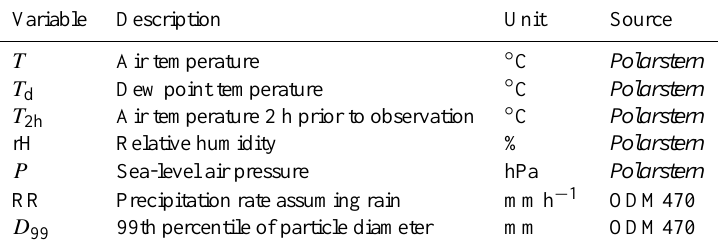
Table 3. List of available meteorological predictor variables in OceanRAIN used in the logistic regression model to predict the PP.